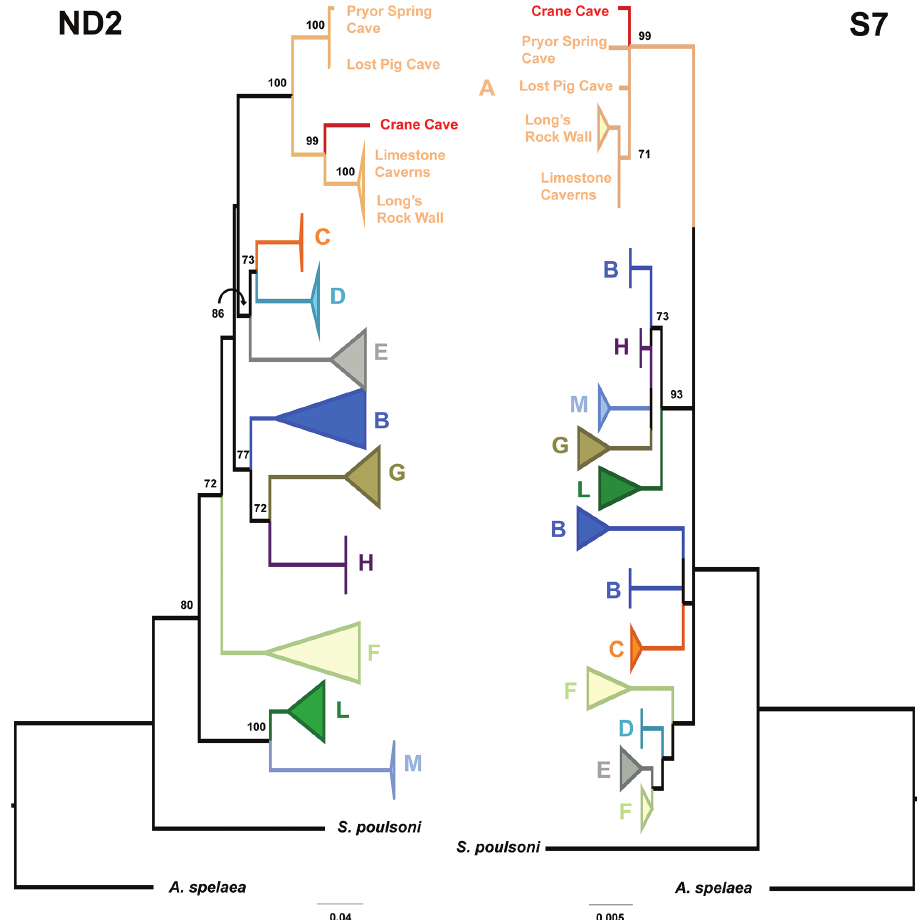
Figure 2. Maximum likelihood gene trees for mitochondrial ND2 (left) and nuclear S7 (right) loci. Colors correspond to genetic lineages for Typhlichthys subterraenus designated in Niemiller et al. (2012b). Boot- strap values are to the left (ND2) or right (S7) of the corresponding node with >0.70 support. Outgroup taxa include Speoplatyrhinus poulsoni and Amblyopsis hoosieri . Scale bar unit: expected substitutions per